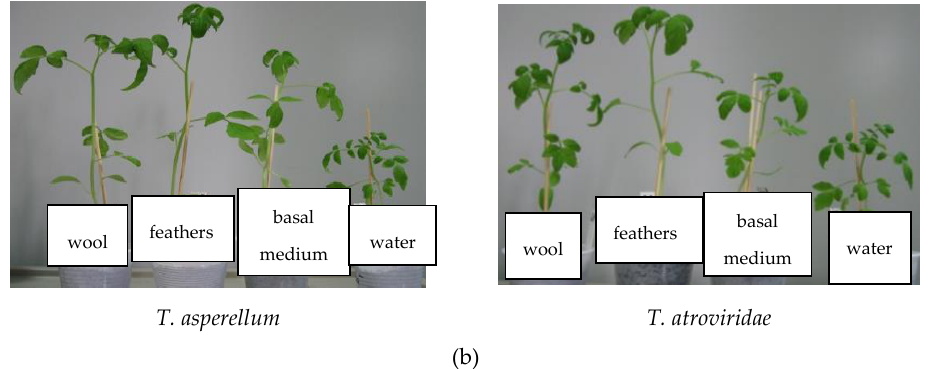
Figure 7. Effect of PHs treatment on the growth of tomato seedlings. ( a ) tomato seedlings after the first treatment with PHs. ( b ) tomato seedlings after the four treatment with PHs.